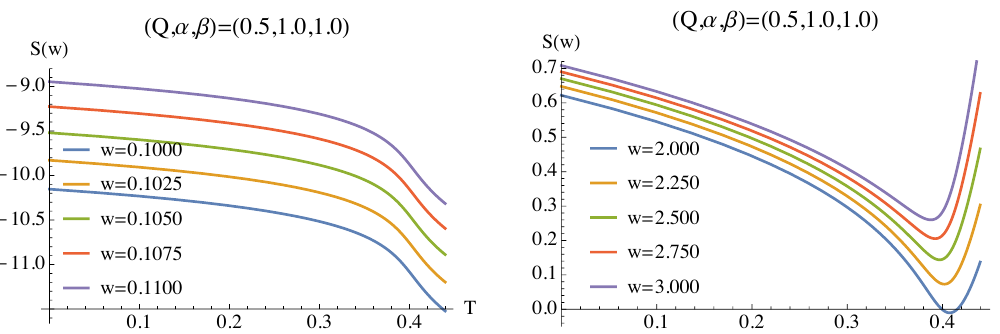
Figure 6 . The relationship between the temperature and the HEE for small (left plot) and large widths (right plot) in absence of thermal phase transitions.